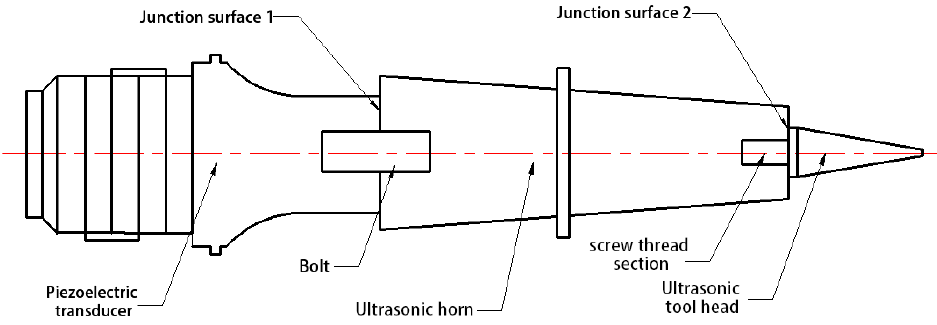
Figure 1. Assembly structure and junction surface distribution of acoustic vibration components.